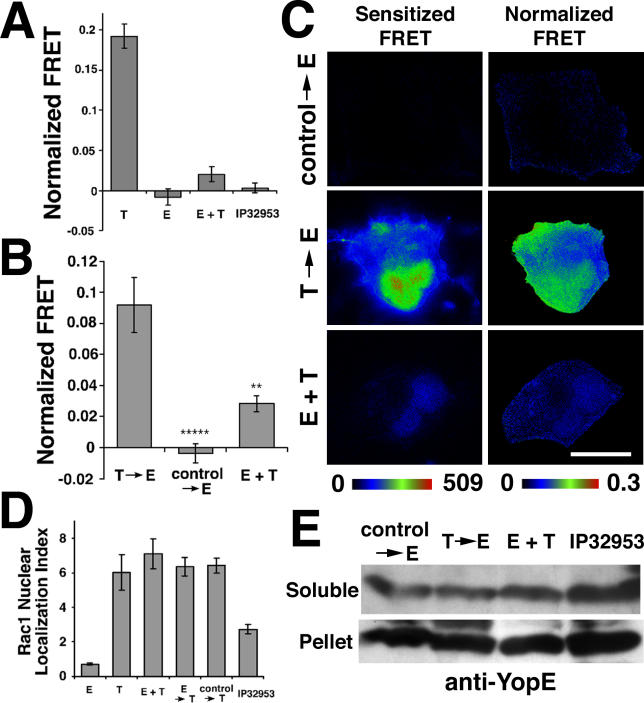
Temporally Regulated Interference of YopE Activity by YopTCOS1 cells cotransfected with mCFP-Rac1 and mYFP-PBD were incubated with the noted strains and processed for FRET analysis using ROIs located within the cytoplasm as in Figure 6 (Materials and Methods).(A) YopE can inactivate cytosolic Rac1 in the presence of YopT. FRET was determined after 30 min of infection with COS1 cells for the following strains. E, YP15 (yopT −yopE +); IP32953, clinical isolate expressing both YopT and YopE; T, YP17/pYopT2 (yopT +yopE −); and E + T, mixed infection of YP17/pYopT2 (yopT +yopE −) and YP15 (yopT −yopE +) added simultaneously to cells.(B) Injection of YopT prior to YopE interferes with Rac1 inactivation by YopE. Control → E, cells were infected with YP17 for 30 min and then incubated with YP15 (yopE +) for 30 min; IP32953, cells were incubated with clinical strain IP32953 (yopT +yopE +) for 1 h; and T → E, YP17/pYopT2 (yopE −) was introduced onto cells for 30 min prior to incubation of YP15 (yopE +) with cells for 30 min more. ***** p < 5 × 10−5; ** p = 0.002. Results from eight cells were quantitated as mean ± SEM.(C) Examples of sensitized FRET and normalized FRET for cells infected with denoted strains, as above.(D) YopT-promoted Rac1 nuclear localization occurs after YopE pretreatment. COS1 cells were incubated with bacteria using the above conditions, with the added protocol of incubating the cells with bacteria expressing YopE for 30 min prior to infection with bacteria that express YopT. E → T, YP15 (yopE +
yopT −) was introduced onto cells for 30 min, prior to incubation of YP17/pYopT2 (yopT +
yopE −) with cells for 30 min more. Results are displayed from the analysis of ROIs in eight to ten cells, with measurement of the nuclear localization index for Rac1 (ratio of Rac1 in the nucleus to that in the cytoplasm; Materials and Methods).(E) Translocation of YopE is unaffected by the presence of YopT in either a serogroup I strain or using coinfection conditions. Infection conditions were as indicated above; translocation was assayed, and the amount of protein was determined by immunoblotting using an anti-YopE antibody in an NP-40 extractible fraction (Materials and Methods). Pellet, protein not extracted by NP40 (associated with bacterial pellet); Soluble, NP40-soluble fraction (translocated).